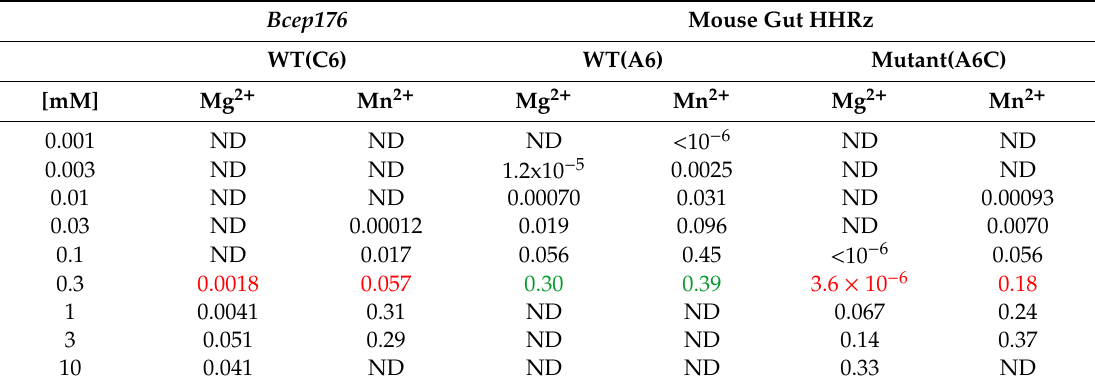
Table 1. Cleavage rates of Bcep176 (C6) variant and pseudoknotted type II mouse gut HHRz (mouse gut HHRz) with comparative Mn 2 + and Mg 2 +